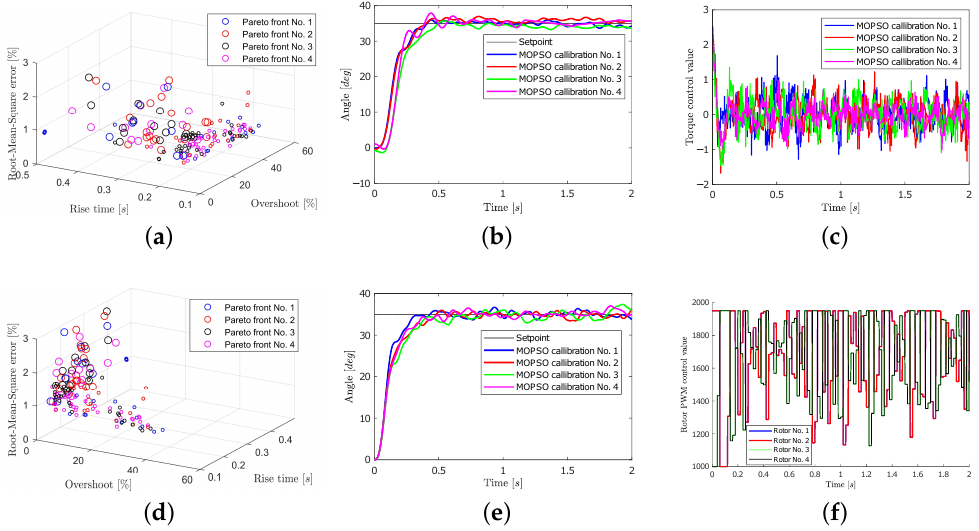
Figure 9. Results obtained for the pitch axis. ( a ) Pareto front (the bigger particles represent the ones without oscillation hazard). ( b ) Experimental step response. ( c ) Torque control values. ( d ) Pareto front in a different perspective. ( e ) Simulation step response. ( f ) PWM control value (calibration number